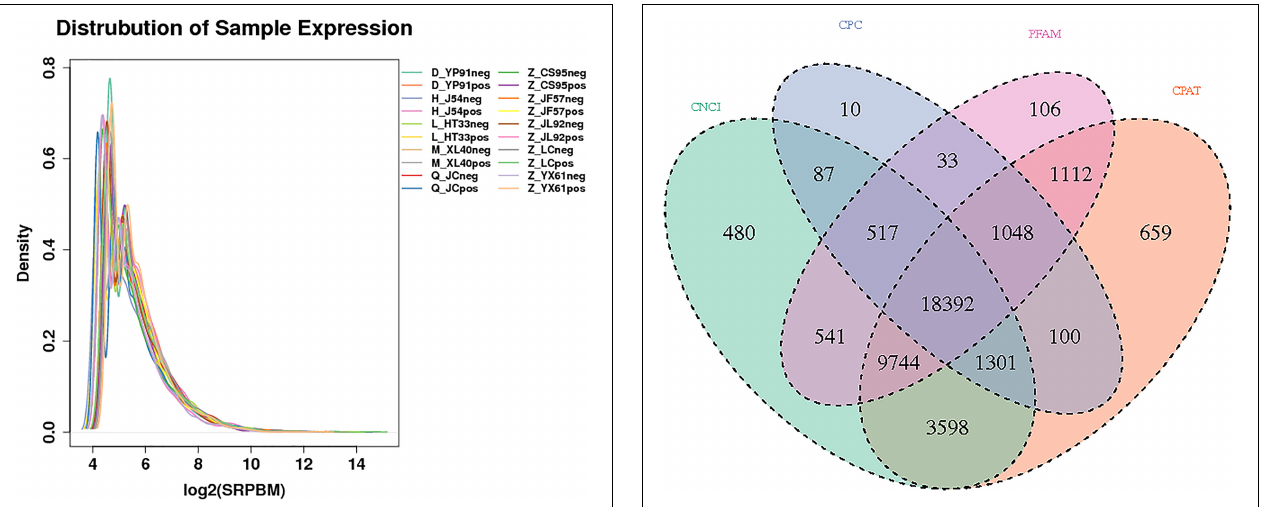
FIGURE 2 | Expression of the density map of circRNAs: For the gene expression of each group of samples, the density distribution was made after taking the logarithm of base 2. The horizontal coordinate was log2 (SRPBM), and the ordinate was the density of genes. Different colors represent different samples.